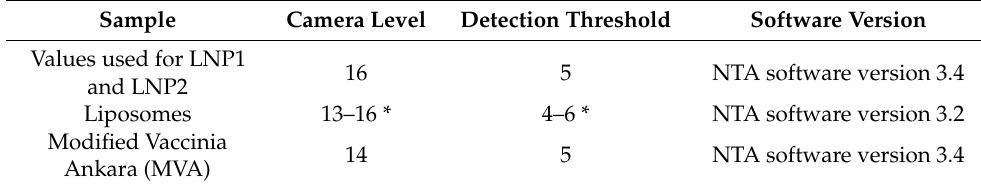
Table 2. Summary of the NTA detection settings for mRNA-LNP